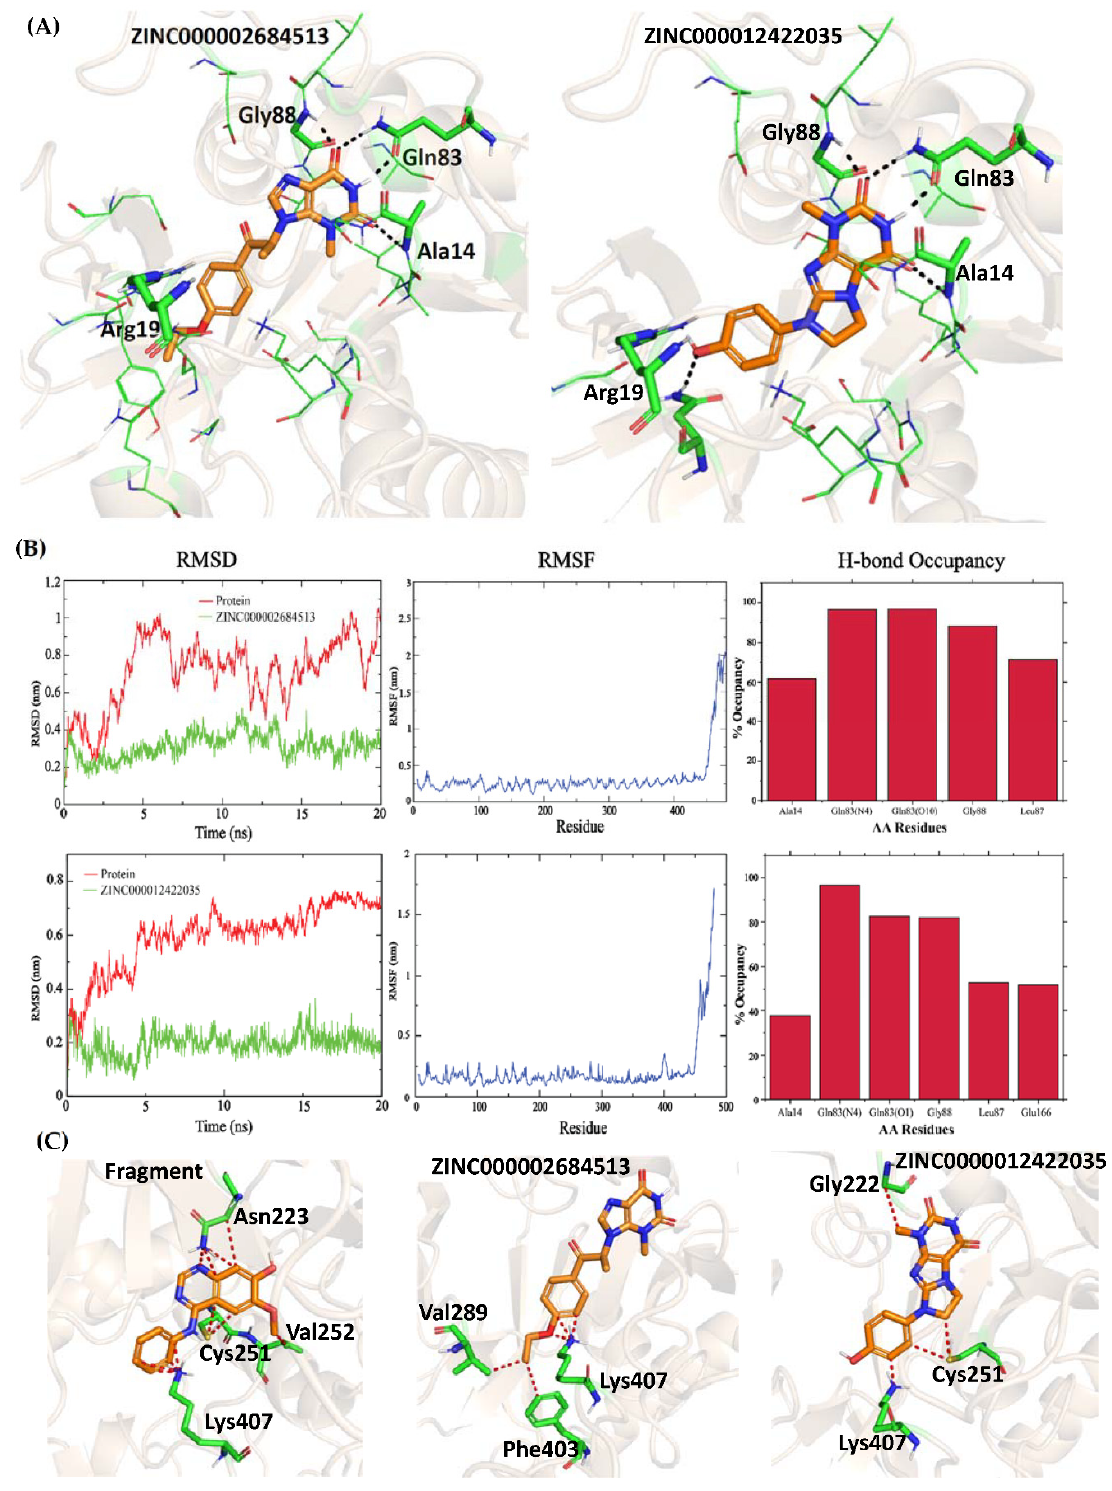
Figure 5. ( A ) Putative binding poses of vs. hits ZINC000002684513 and ZINC000012422035 ( B ) MD simulation of ZINC000002684513 and ZINC000012422035 for 20ns. ( C ) Overlay of Fragment and the three vs. hits ZINC000002684513, and ZINC000012422035 in human AGX1 (PDB ID: 1JV1). Ugly clashes are shown in red